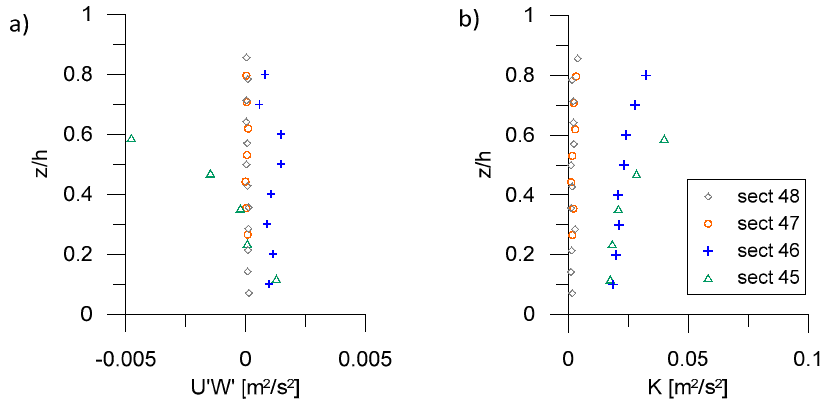
Figure 6. Test_S: vertical profiles of the time-averaged turbulent Reynolds stresses (a) and turbulent kinetic energy (b).